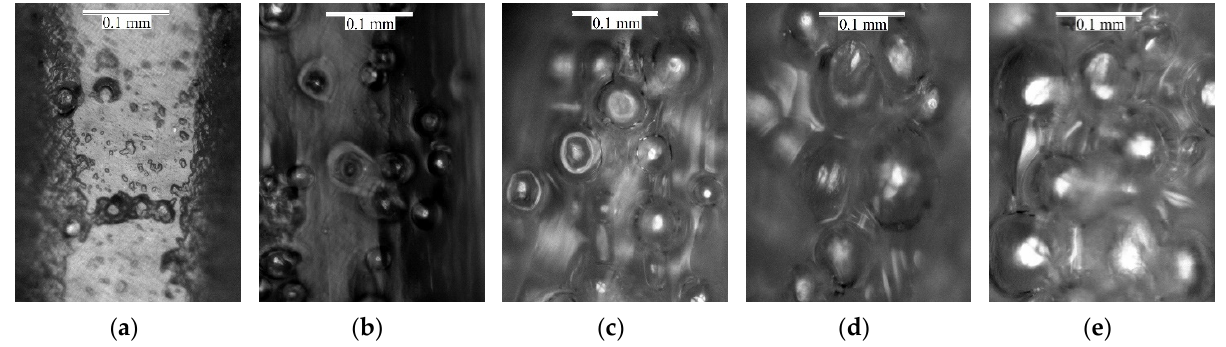
Figure 1. Microscopic images of 3D printed samples in different printing temperature: ( a ) 215 °C, ( b ) 220 °C, ( c ) 225 °C, ( d ) 230 °C, ( e ) 250 °C.